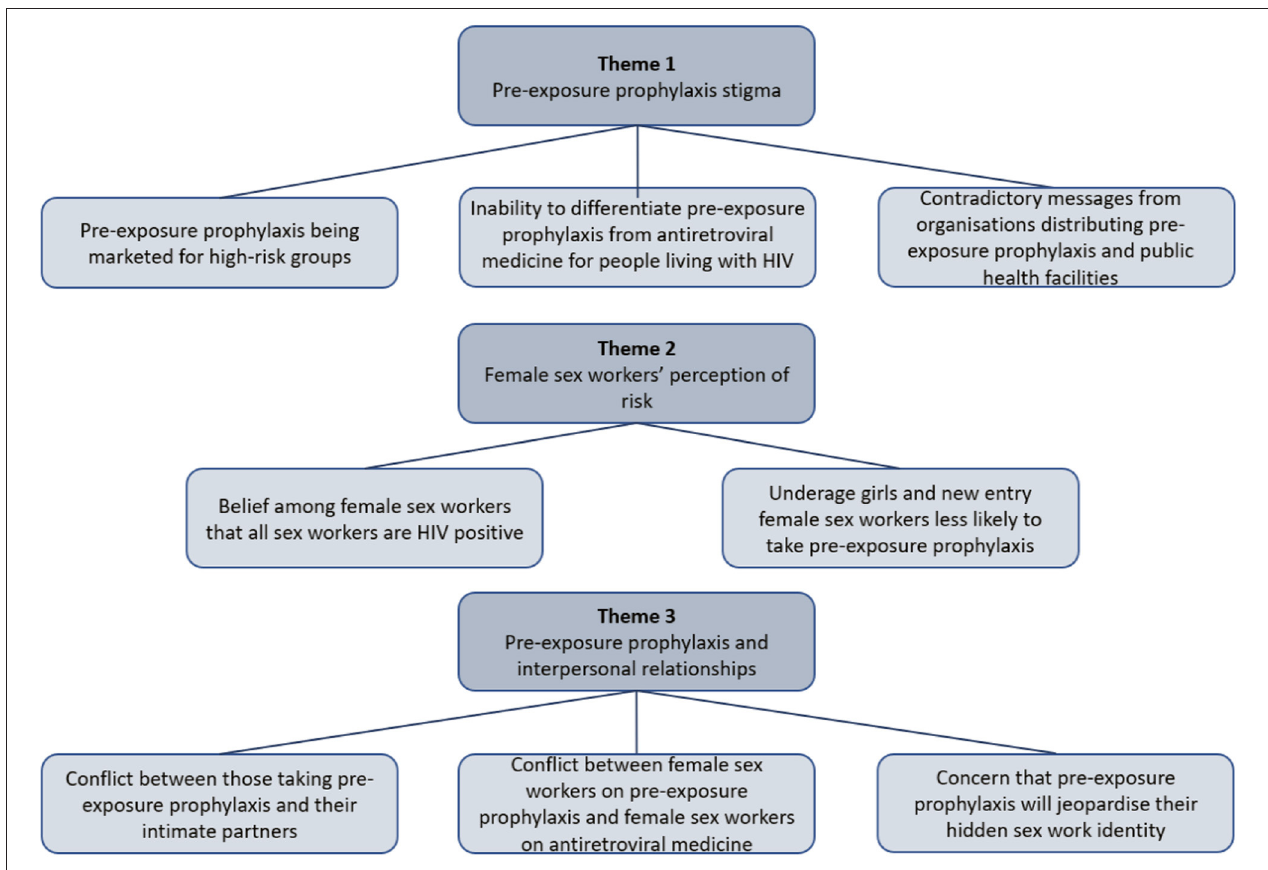
FIGURE 1 | Themes and